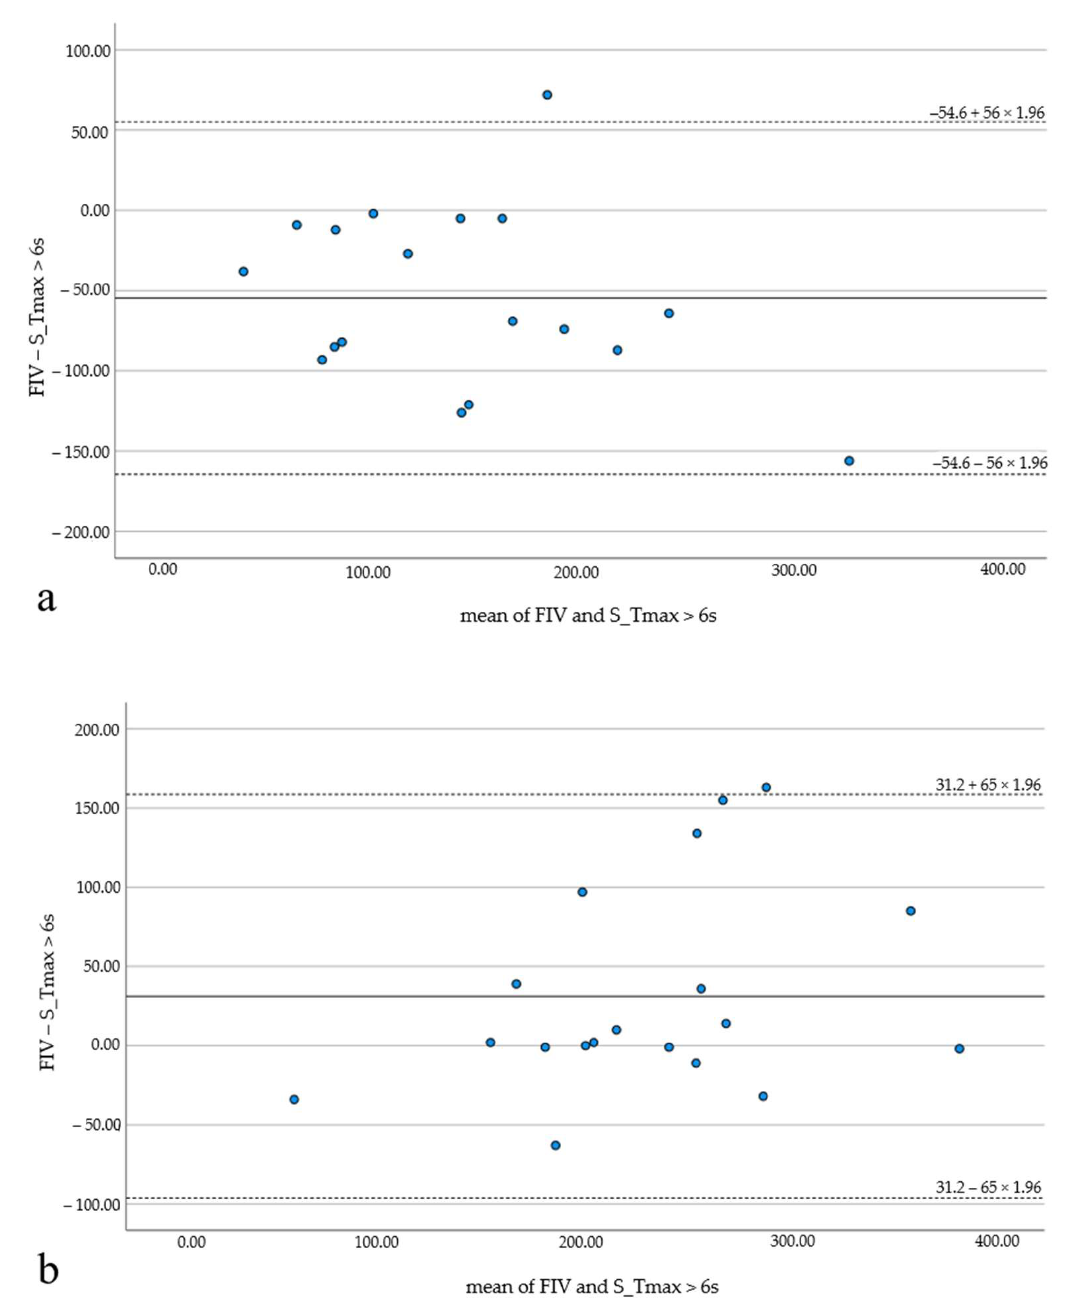
Figure 5. Bland–Altman plots illustrating the results of the subgroup analysis (HIR ≥ 0.6 and HIR < 0.6) with package C. The FIV is significantly overestimated in the subgroup with favorable HIR ( a ), while it is significantly underestimated in the subgroup with unfavorable HIR ( b ).